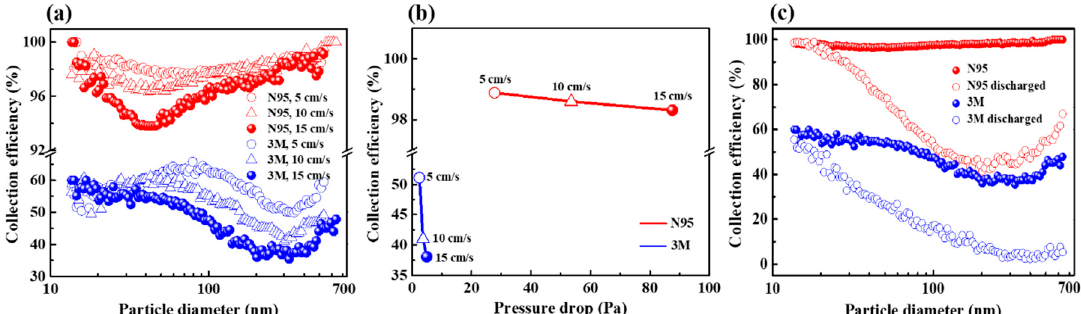
Figure 2. ( a ) Collection efficiency of the N95 and 3M filters at different face velocities. ( b ) Collection efficiency versus pressure drop of the N95 and 3M filters as a function of face velocity. ( c ) Collection efficiency of the N95 and 3M filters before and after treatment with IPA.